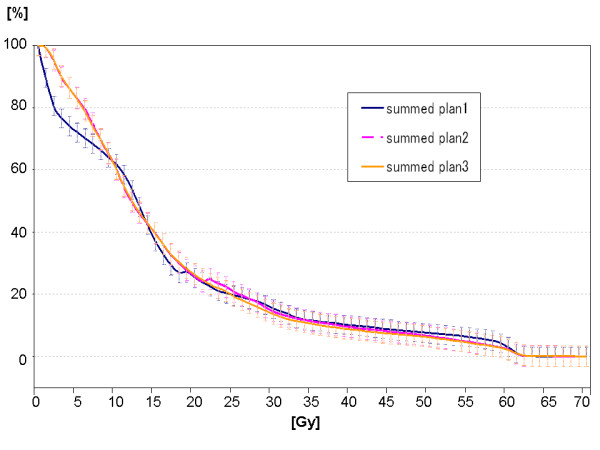
Mean DVH (whole curve) of small bowel PRV in each summed plan.